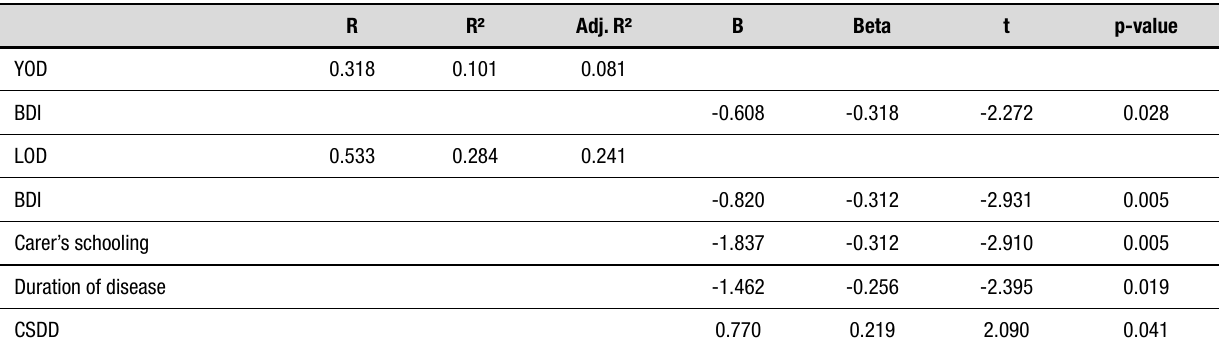
Table 3. Regression model of factors related to